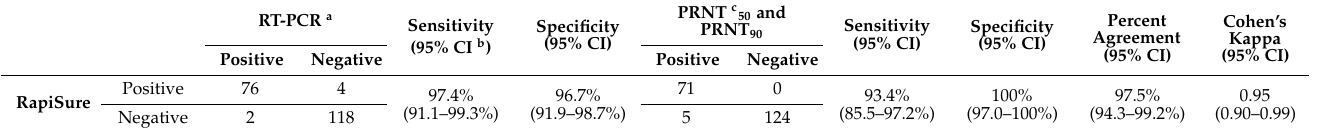
Table 1. Performance of RapiSure COVID-19 S1 RBD IgG/Neutralizing Ab Test compared to the results of COVID-19 RT-PCR and PRNT 50 /PRNT 90. The RapiSure S1 RBD IgG test results were compared with those of RT-PCR, and the Neutralizing Ab test results were compared with those of PRNT,